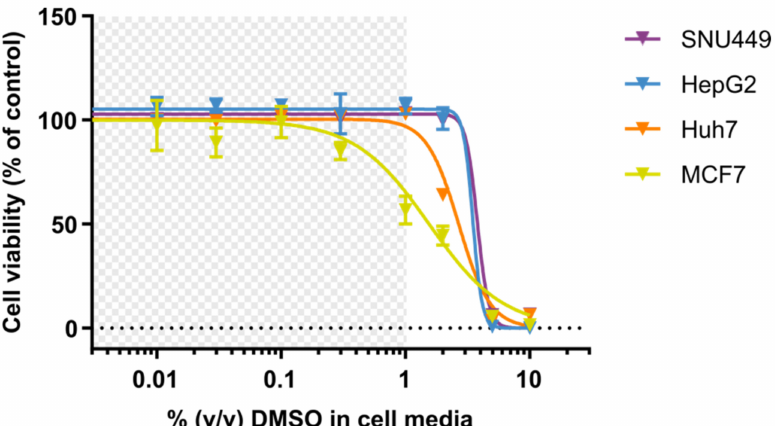
Figure 2. The mean ( ± SD) cell viability after 72 h treatment with the solvent DMSO in a concentration range of 0.01–10% DMSO in cell media. The different cell lines (SNU449 in purple, HepG2 in blue, Huh-7 in orange and MCF7 in yellow) were given CCM Fed containing DMSO at different concentrations. The DMSO concentration range 0 to 1% DMSO (grey area) was applied during DOX S treatment.